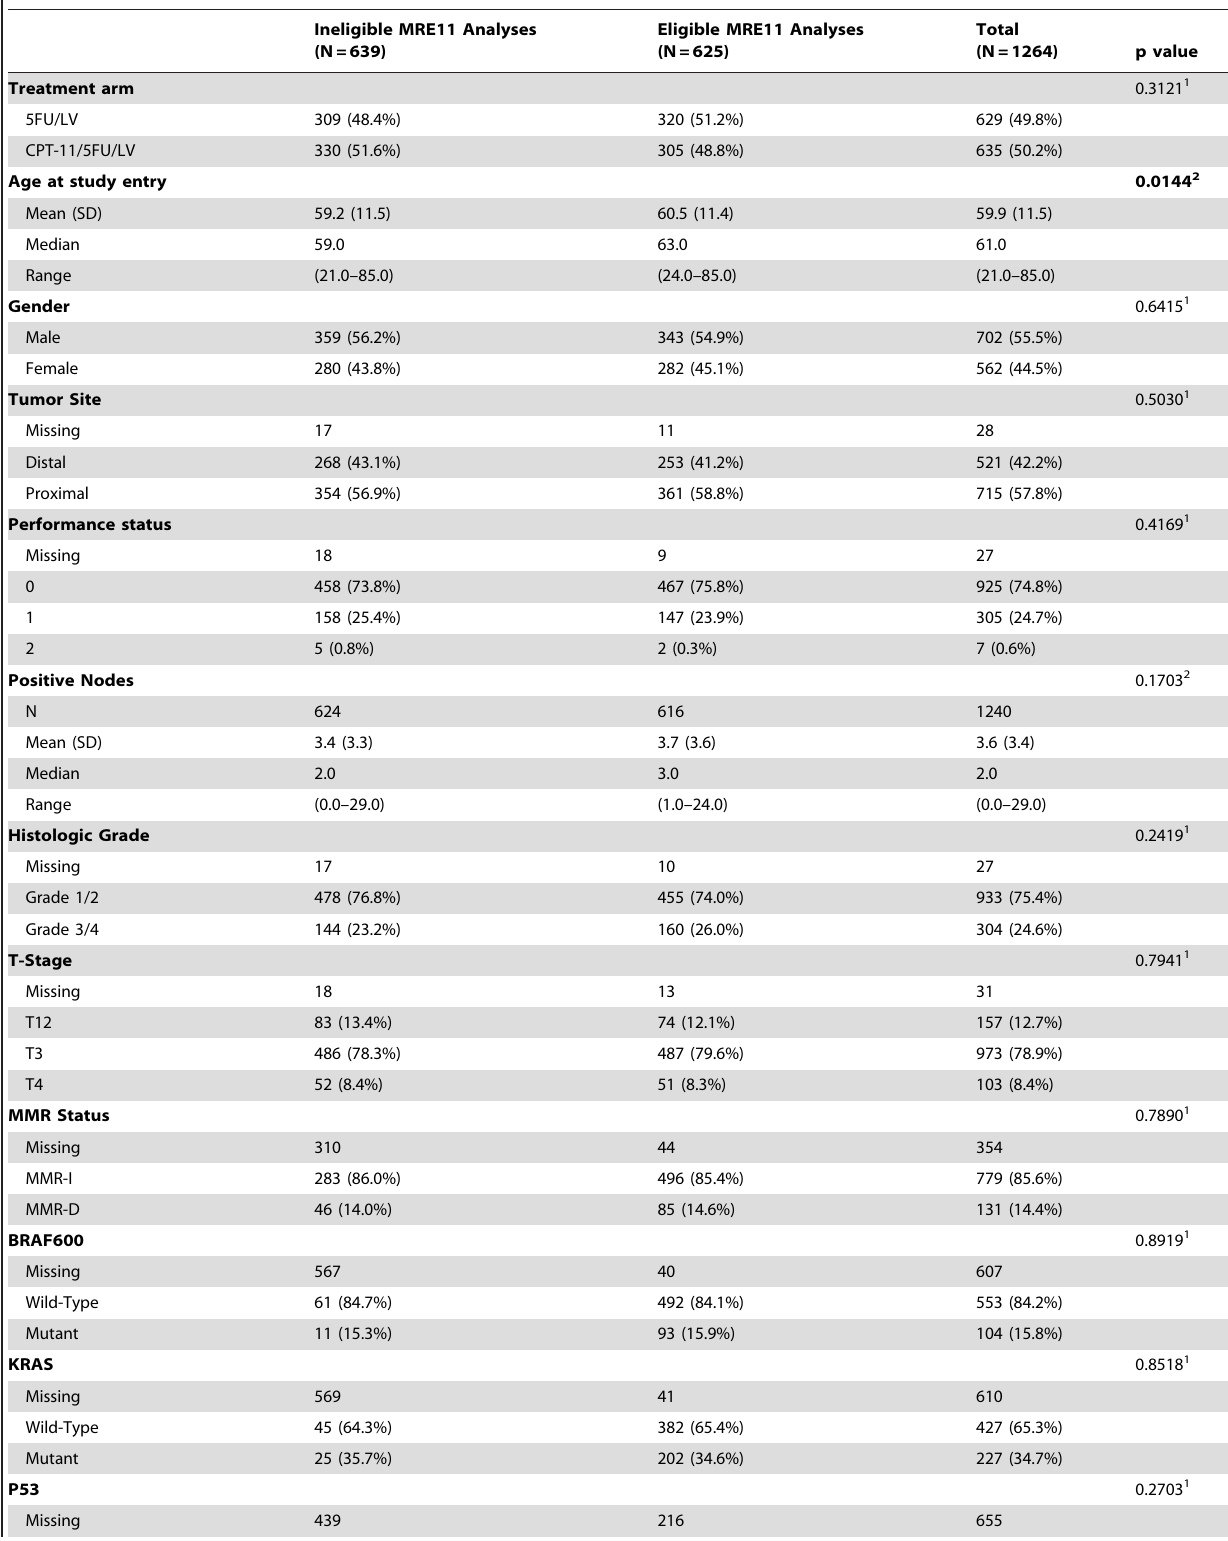
Table 1. Demographics of Study Population by MRE11